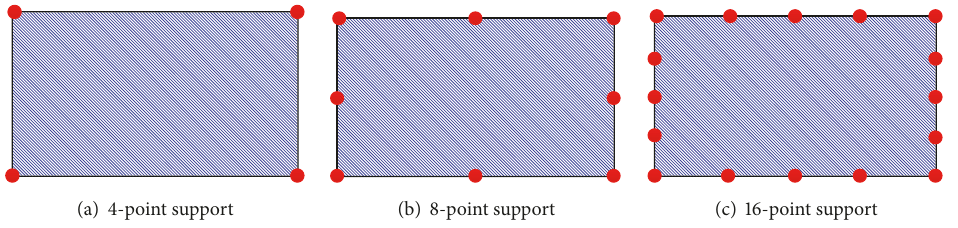
Figure 2: Laminated plate with various multipoints supported boundary